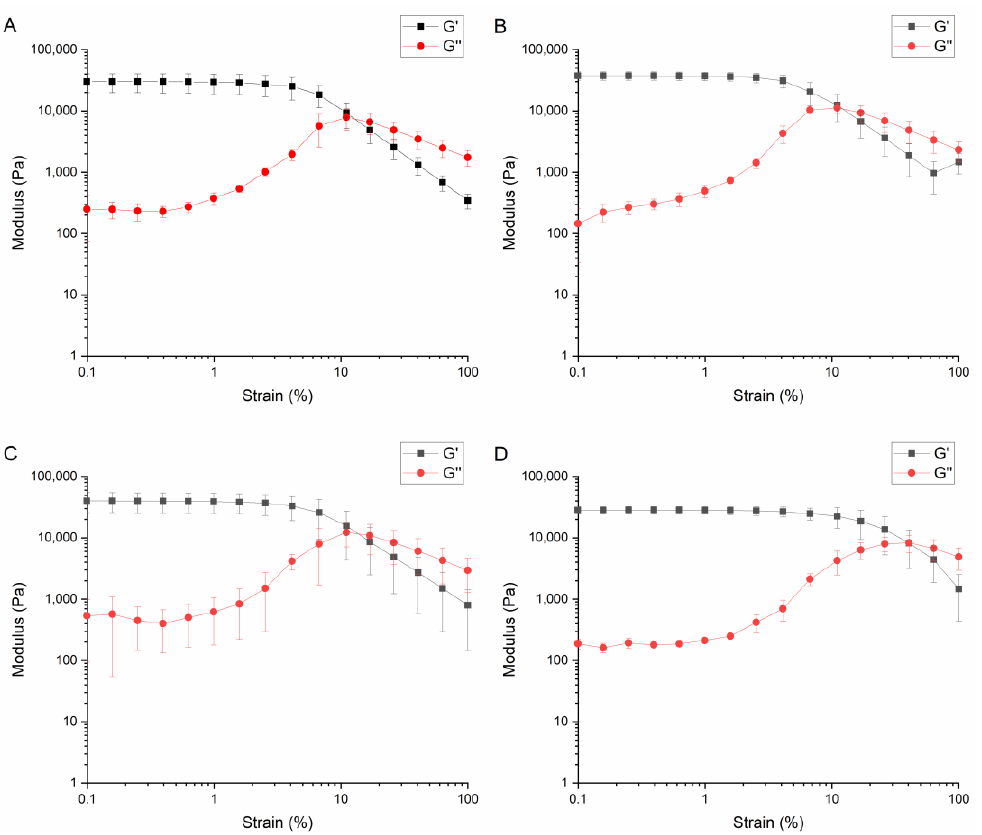
Figure 3. Storage (G′) and loss (G″) modulus of PEG-D6 ( A ), PEG-D6-Si ( B ), PEG-D4-Si ( C ), and PEG-D8-Si ( D ).